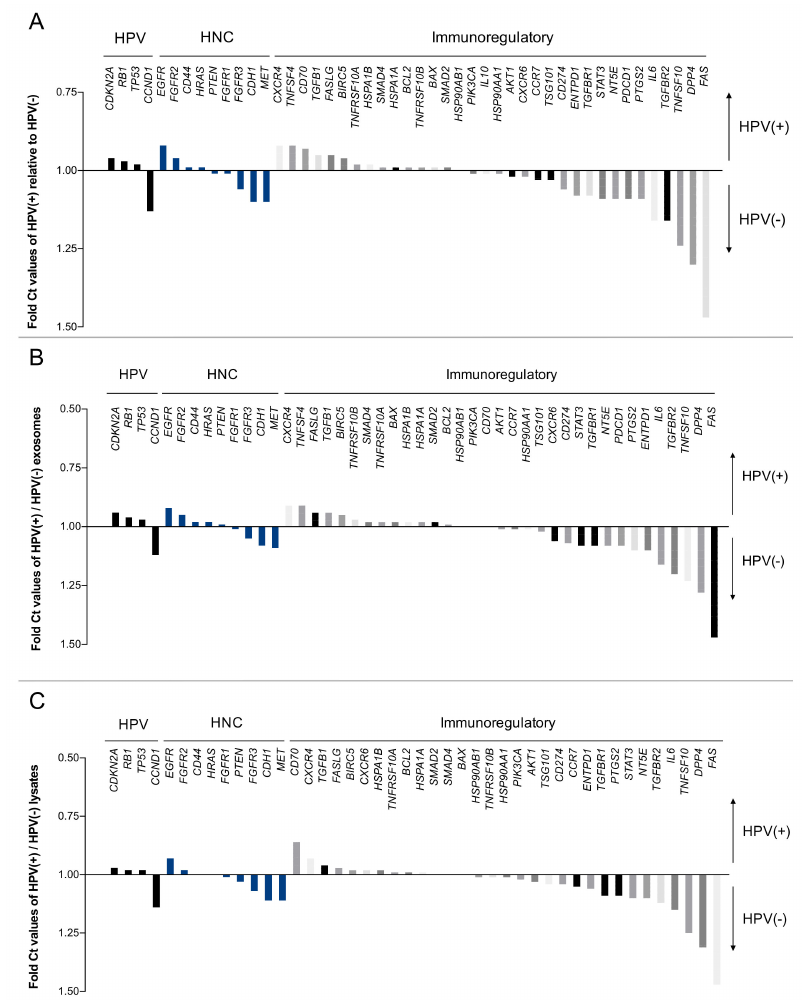
Figure 3. The HPV-status determines the mRNA expression profile in cell lines and exosomes. To calculate fold Ct values, means of absolute Ct values from HPV( + ) samples were divided by HPV( − ) results ( A ). Relative mRNA expression was examined within exosomes ( B ) and HPV cell lysates ( C ). The data are presented as waterfall plots and indicate overexpression of several immunoregulatory mRNAs within HPV( − ) cell lysates and / or exosomes compared to HPV( + ). The data are shown in fold Ct values on an inverted scale